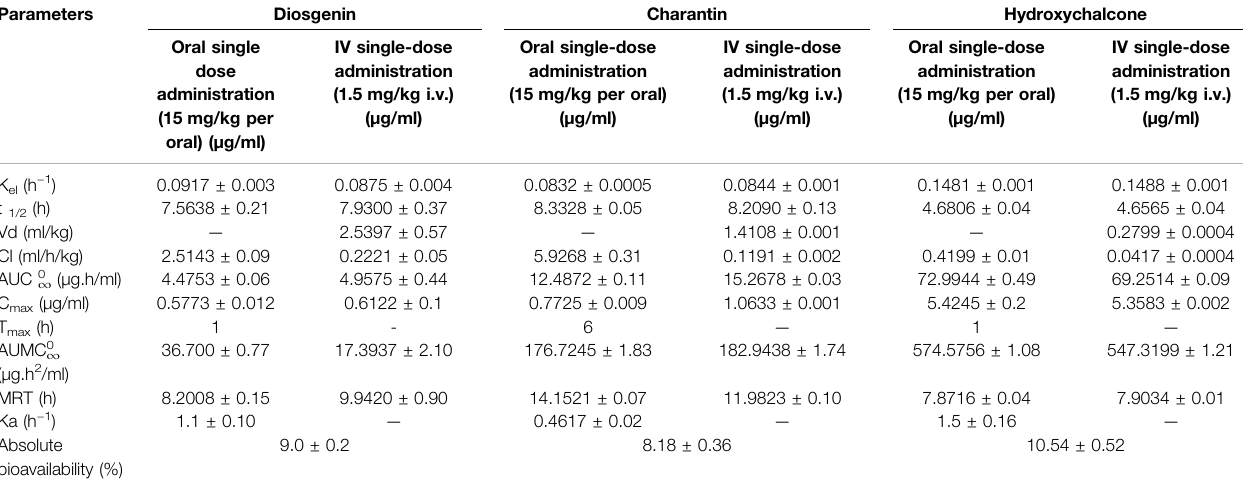
TABLE 8 | Mean ( ± SD) pharmacokinetic parameters and absolute bioavailabilities for diosgenin, charantin, and hydroxychalcone in rats after a single dose administration. Parameters Diosgenin